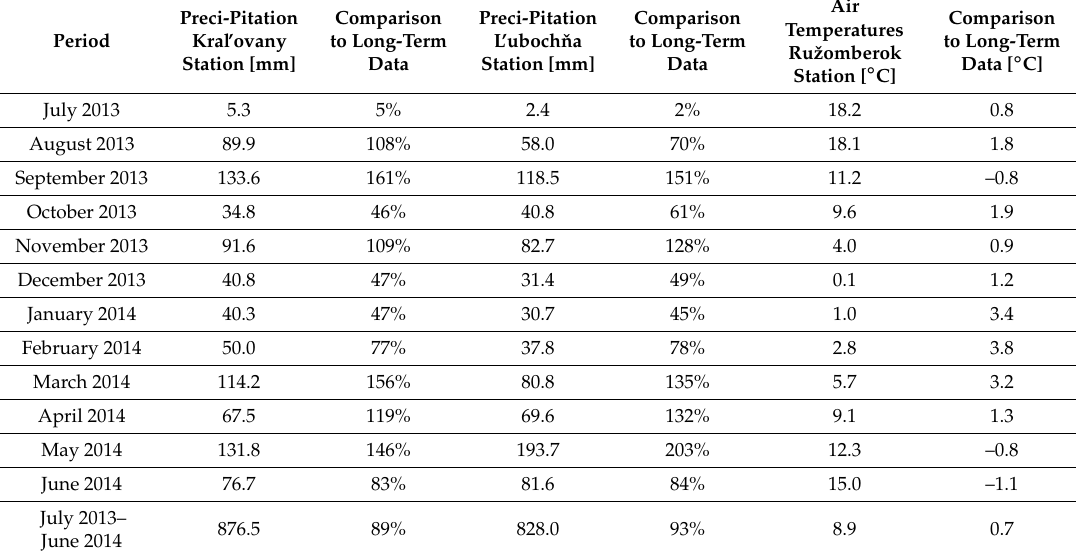
Table 4. Observed monthly precipitation totals and air temperatures in the period of July 2013–June 2014 at stations Kral’ovany, L’ubochˇna, and Ružomberok compared to the mean values of the 1981–2018 period.